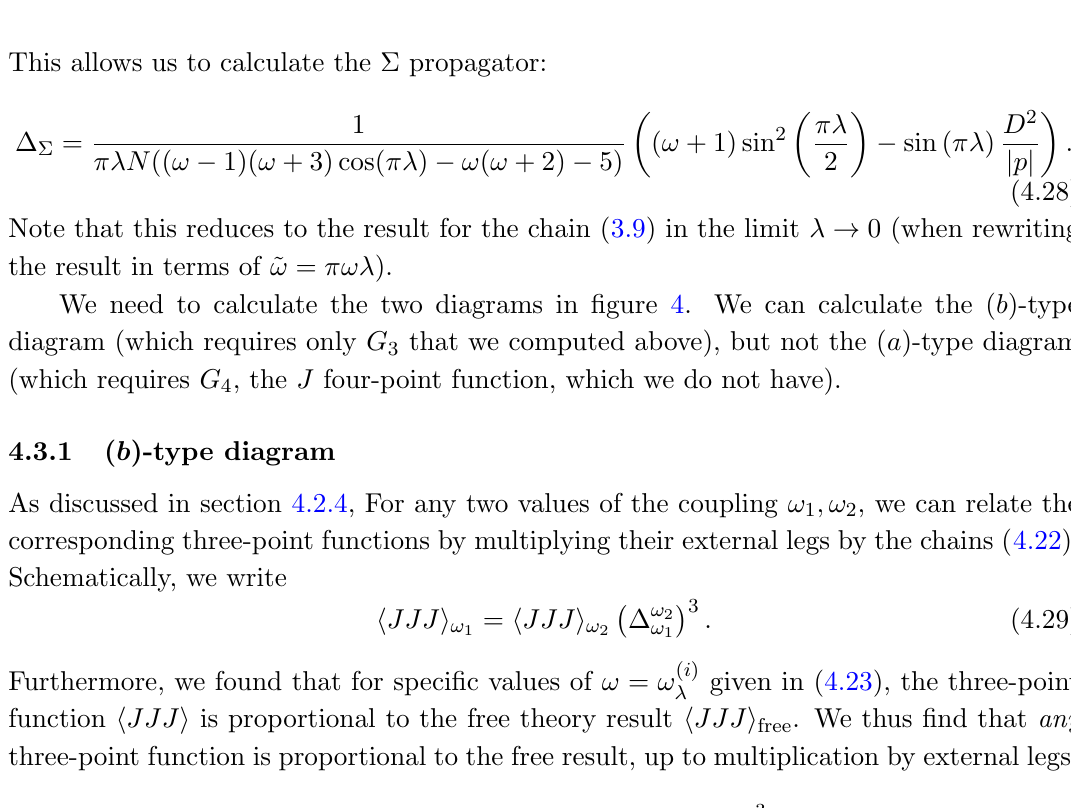
Figure 11. Simplifying the ( b )-type